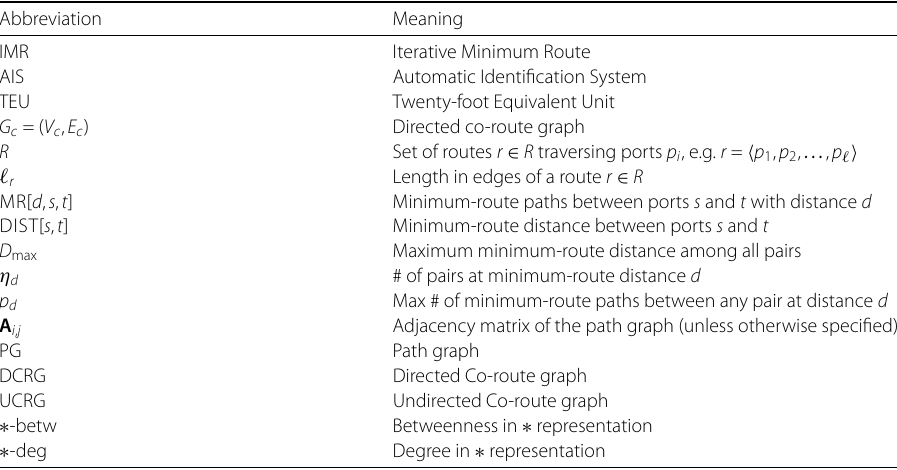
Table 1 List of Abbreviations &